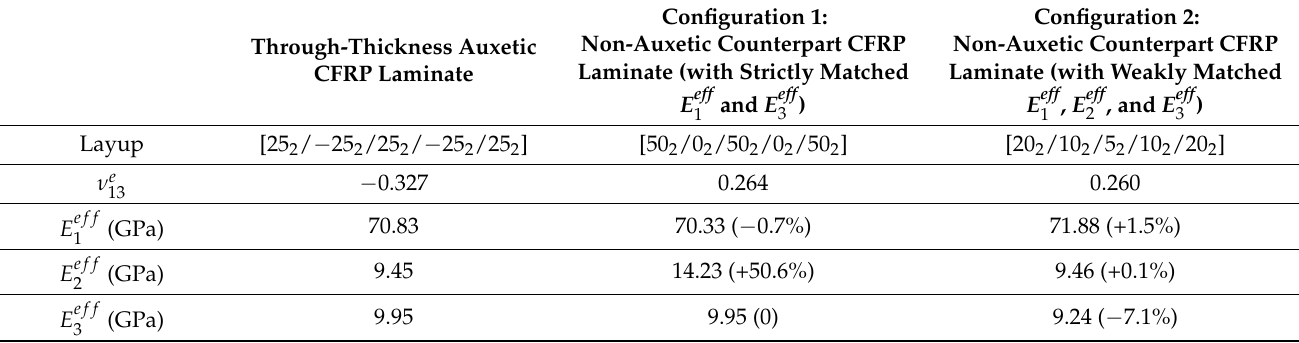
Table 2. Layups of the auxetic laminate and the corresponding non-auxetic counterpart composite laminates in two